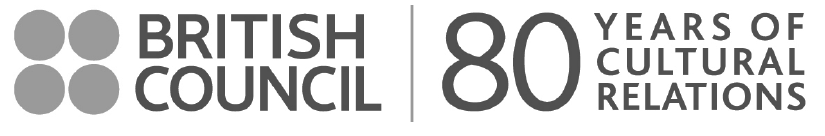
Fig. 3. British Council 80 th anniversary emblem and